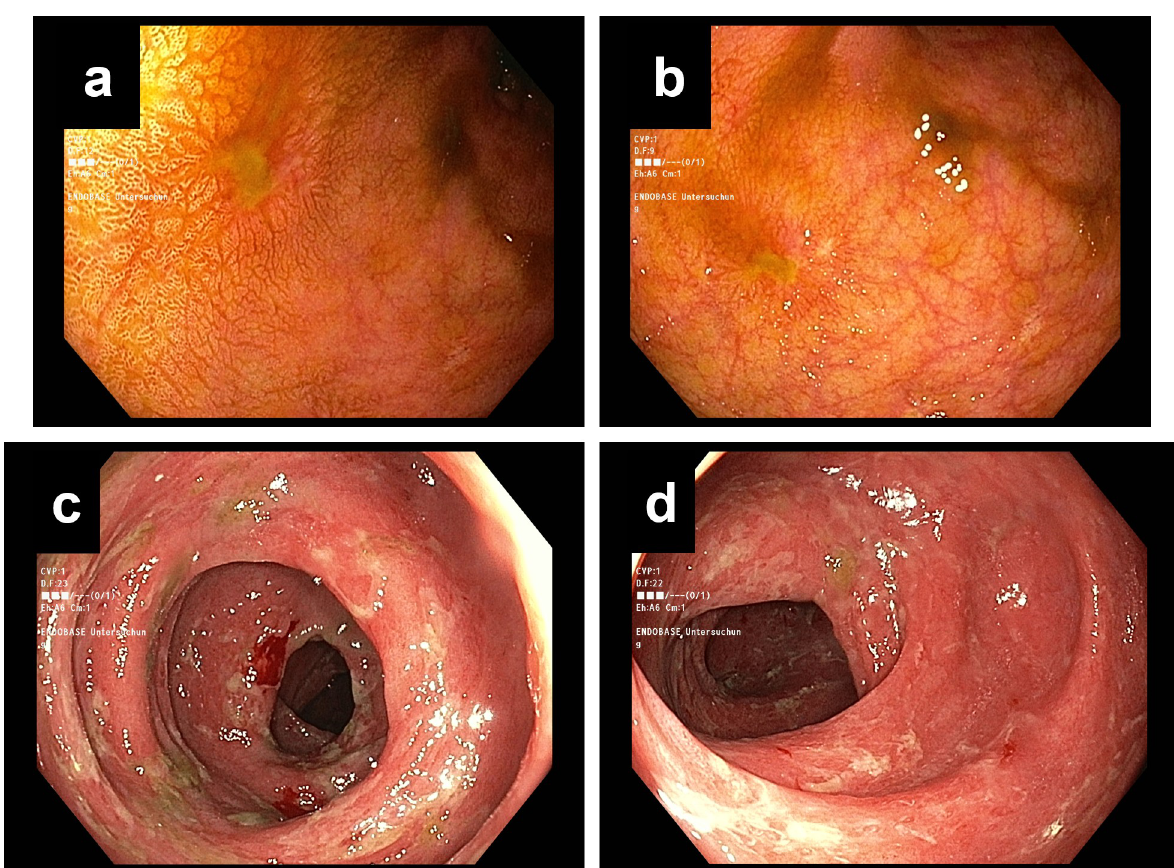
Fig 3. Endoscopic imaging of colonic manifestation of GvHD. Mild colitis with small erosions and very mild localized edema (A, B). Severe changes with generalized, pronounced edema, fibrinous exudation and multifocal granular ulceration (C, D).